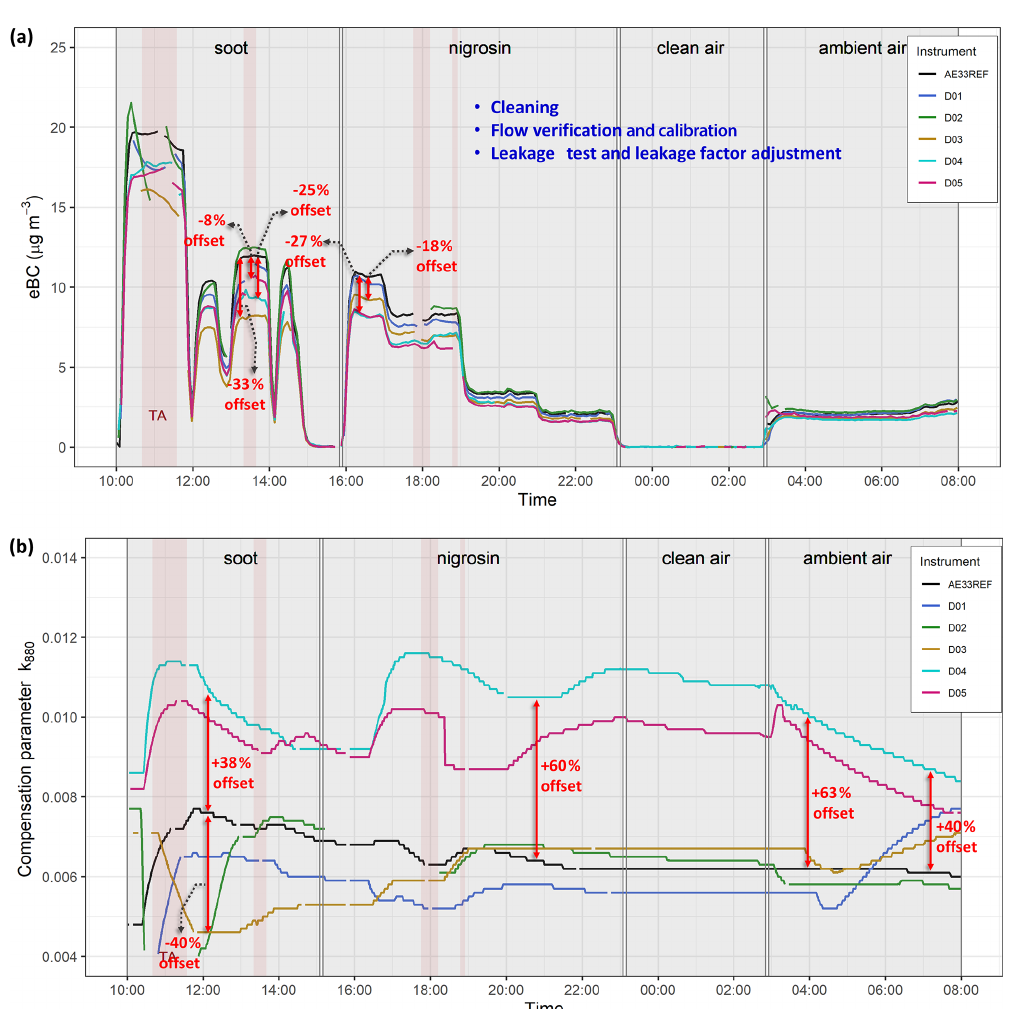
Figure 6. Time series of (a) eBC mass concentrations at 880nm and (b) compensation parameters k 880 after the initial phase of maintenance in group D. Areas outlined in gray show the periods of clean air and aerosol supply; red bars indicate times when tape advances occurred in more than one instrument simultaneously.